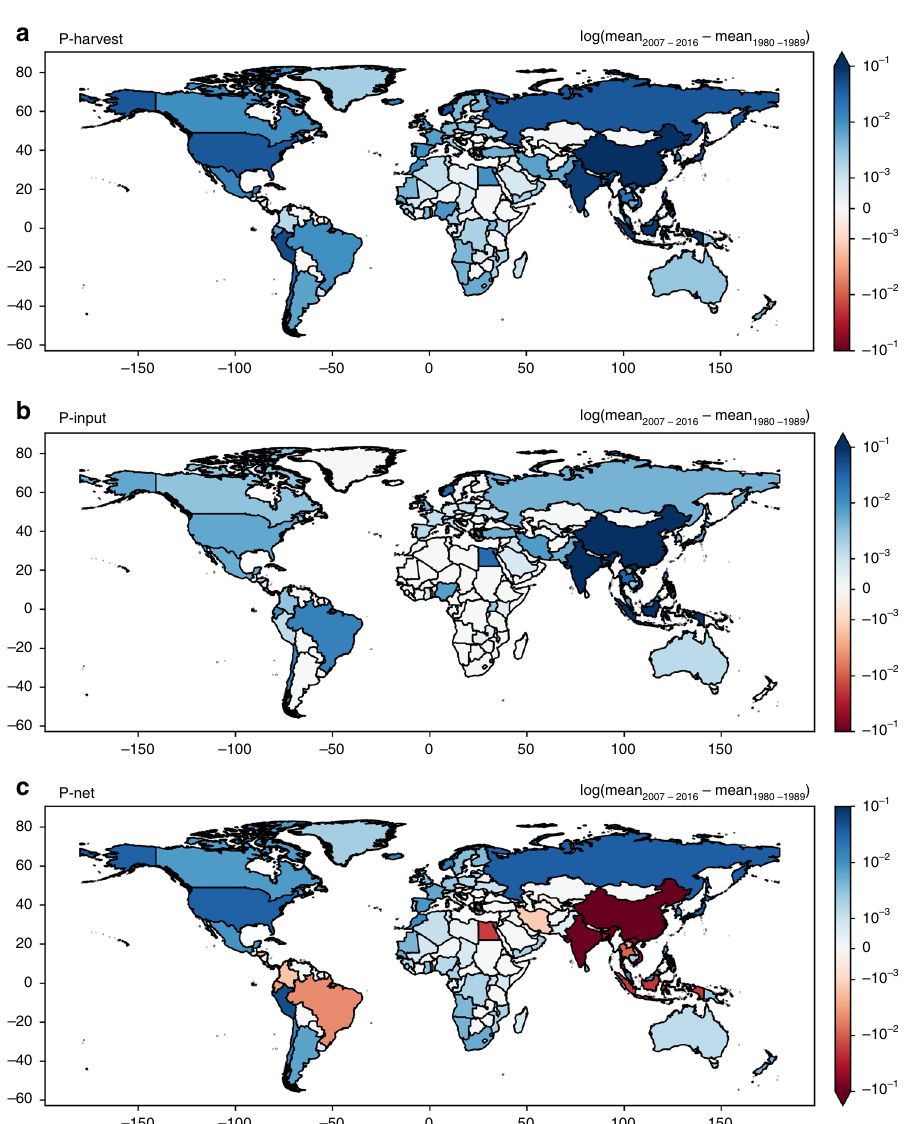
Fig. 4 Changes in the global fi shery P budget. ( a ) P-harvest, ( b ) P-input, and ( c ) P-net between the 1980s and the recent decade (2007 – 2016). Note the log scale on the color legend and that the units are in Tg P yr − 1 . Country borders are adapted from TM World Borders Dataset 0.3.